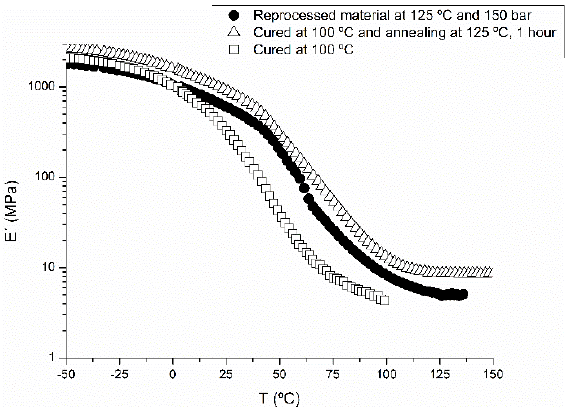
Figure 14. Storage modulus of the samples 5050DSS before reprocessing, after reprocessing, and after annealing at 125 °C for 1 h.